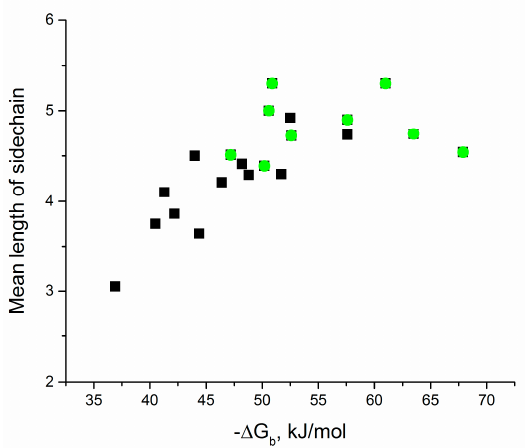
Figure 3. Selection of high-affinity complexes based on the parameters of the interface. Complexes with high values of the parameters of the number of polar contacts (PC), the mean length sidechain of amino-acid-formed PC and amino acids within 4 Å proximity to “hot spots” (HS), and the total number of atoms in amino acids within 4 Å proximity to HS (green dots) have the highest changes in Gibbs free energy during binding compared to other complexes (black dots).